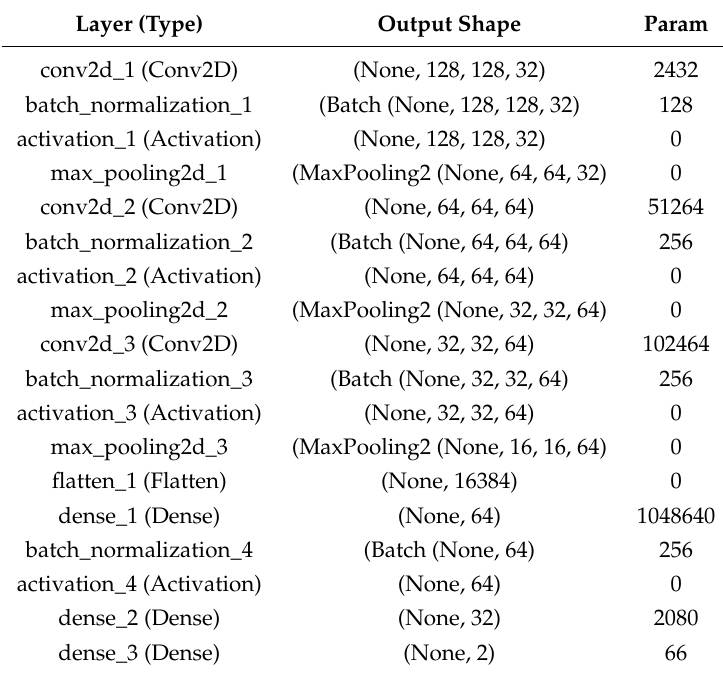
Table 3. CNN model architecture description.